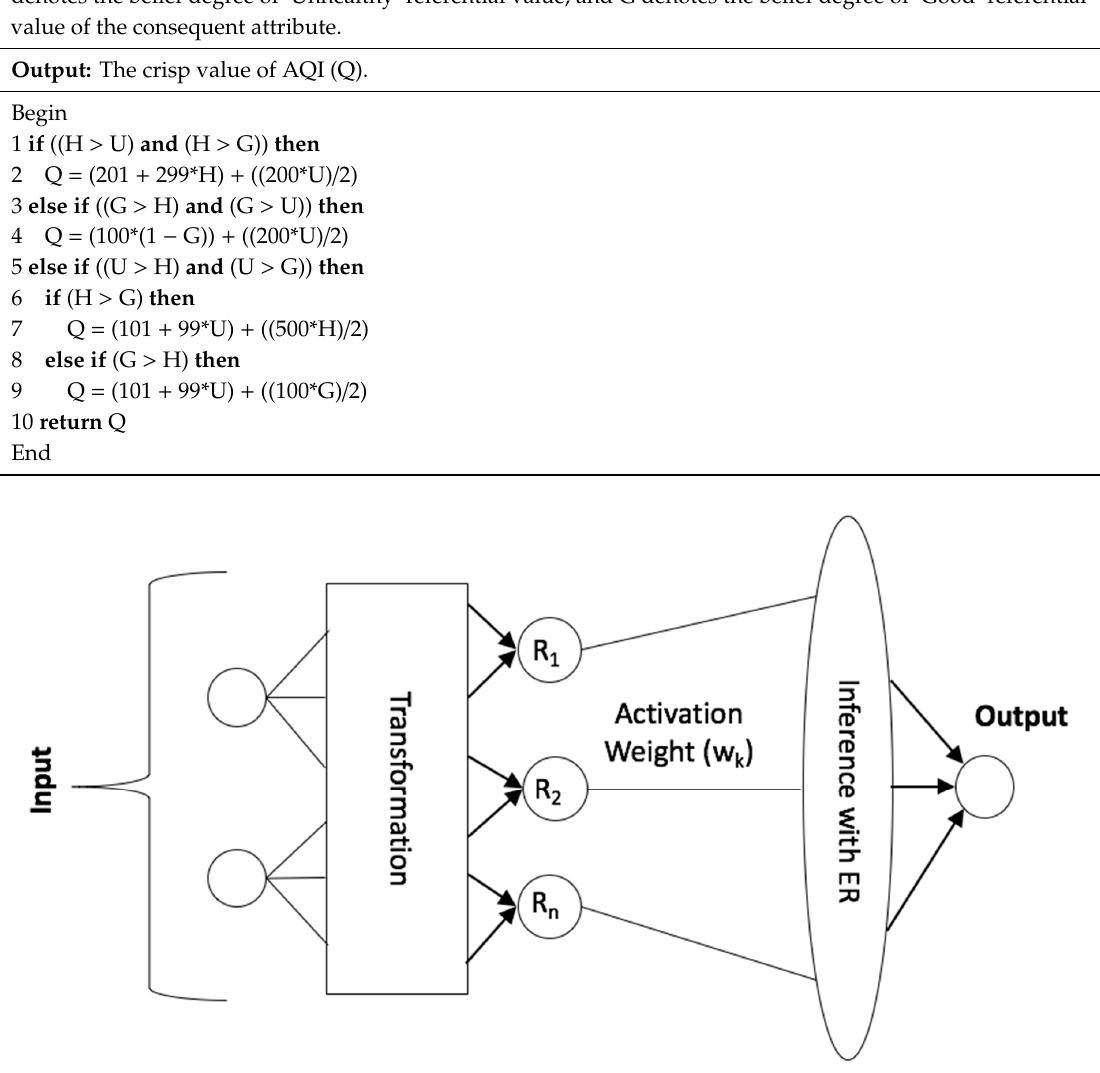
Algorithm 3: an algorithm to calculate single numerical crisp value of AQI